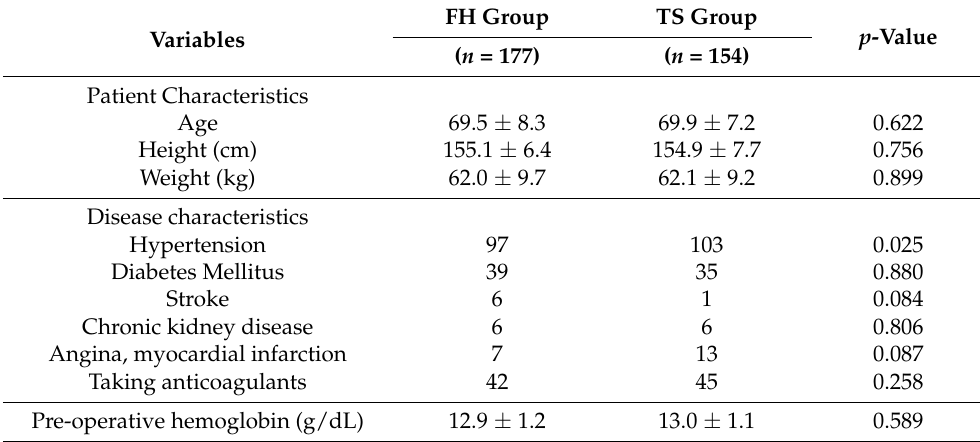
Table 1. Characteristics of patients.